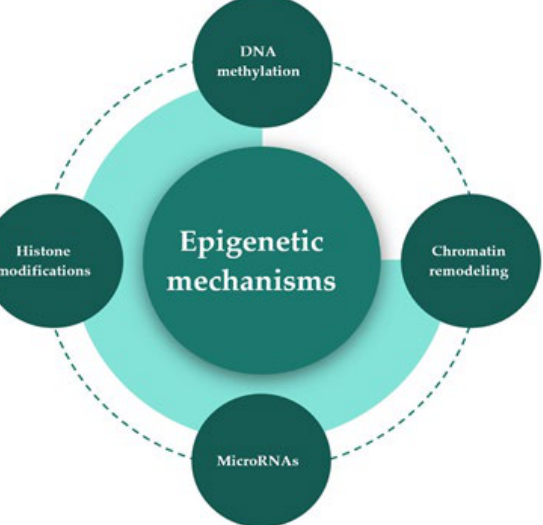
Figure 1. Epigenetics mechanisms. This is a schematic view of the epigenetic mechanisms that regulate gene expression. They are interrelated and include DNA methylation, histone modifications, chromatin remodeling, and the role of microRNAs.